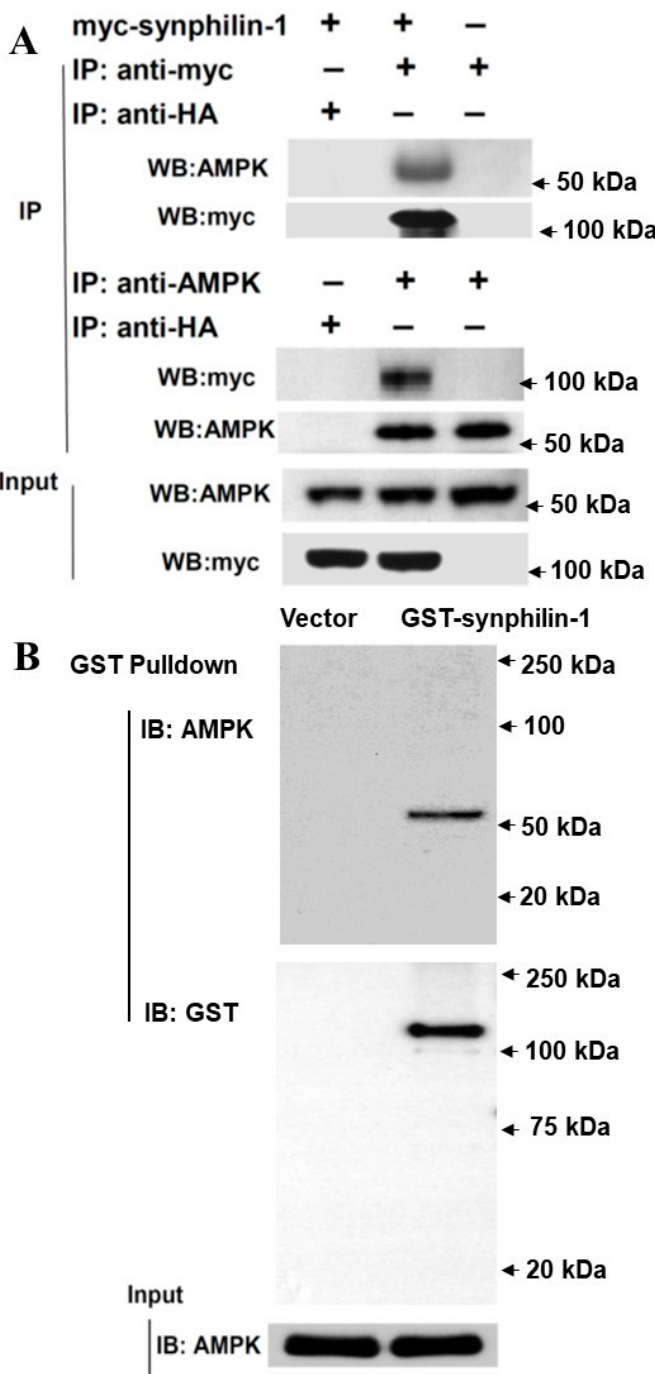
Figure 2. Synphilin-1 interacts with AMPK. ( A ). Lysates prepared from HEK 293 cells transfected with myc-tagged human synphilin-1 cDNA were subjected to IP with anti-myc, anti-HA, or anti-AMPK, followed by anti-AMPK, and anti-myc immunoblotting. Top: Anti-myc antibody precipitated myc-tagged synphilin-1 and AMPK. Middle: Anti-AMPK antibody precipitated AMPK and myc-tagged synphilin-1. Bottom: input blots showing the equal protein loading. ( B ). GST pull-down assays. Top: GST-beads were used to pull-down GST-tagged synphilin-1 and then followed by immunoblotting using anti-AMPK and anti-GST antibodies. Bottom: immunoblotting analysis of input lysates using anti-AMPK antibodies.